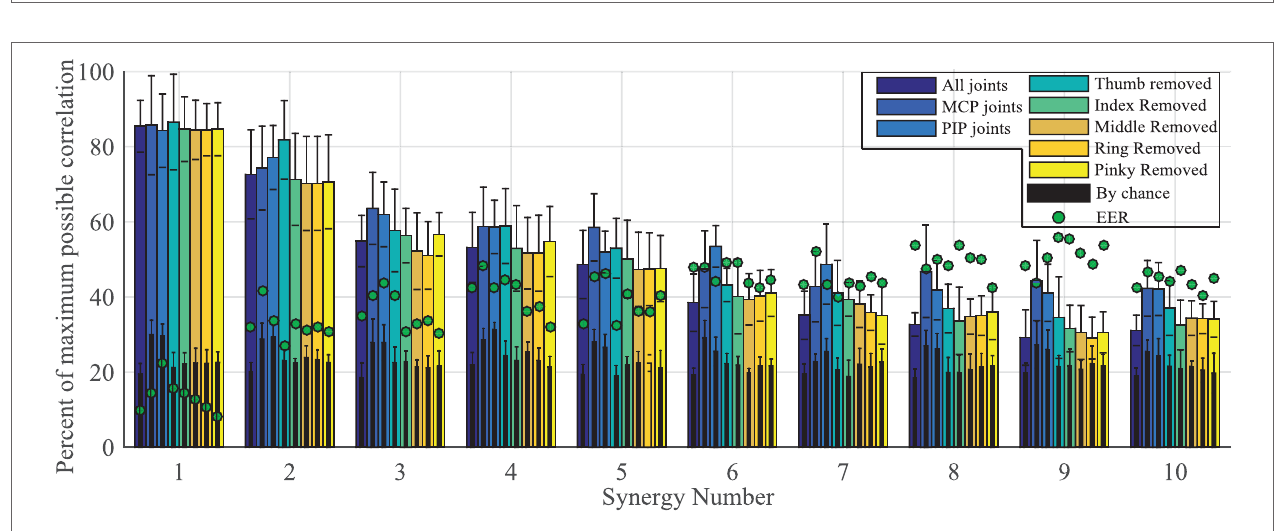
FigUre 5 | across subjects, the mean (bars) and sD (error bars) of correlation values between template and entry movement synergies are shown . Values are shown for different joint configurations: all joints are used, only metacarpophalangeal (MCP) joints are used, only proximal interphalangeal (PIP) joints are used, thumb joints are removed, index joints are removed, middle joints are removed, ring joints are removed, and pinky joints are removed. Black bars show correlation by chance. Green dots show the calculated equal error rate (EER) for each synergy and configuration. Synergy 1 has the highest correlation and lowest EER values. All synergies had correlations above chance level (black